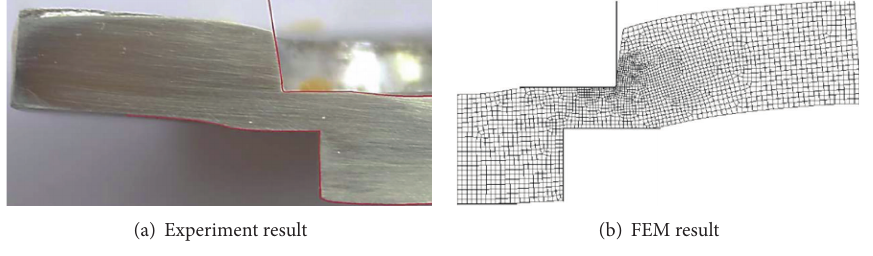
Figure 5: Comparison between actual part and FEM